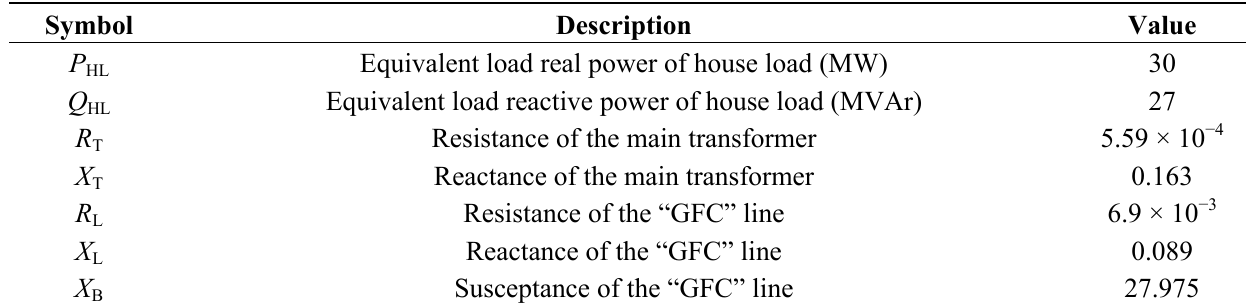
Table A4. Other parameters for PSCAD/EMTDC